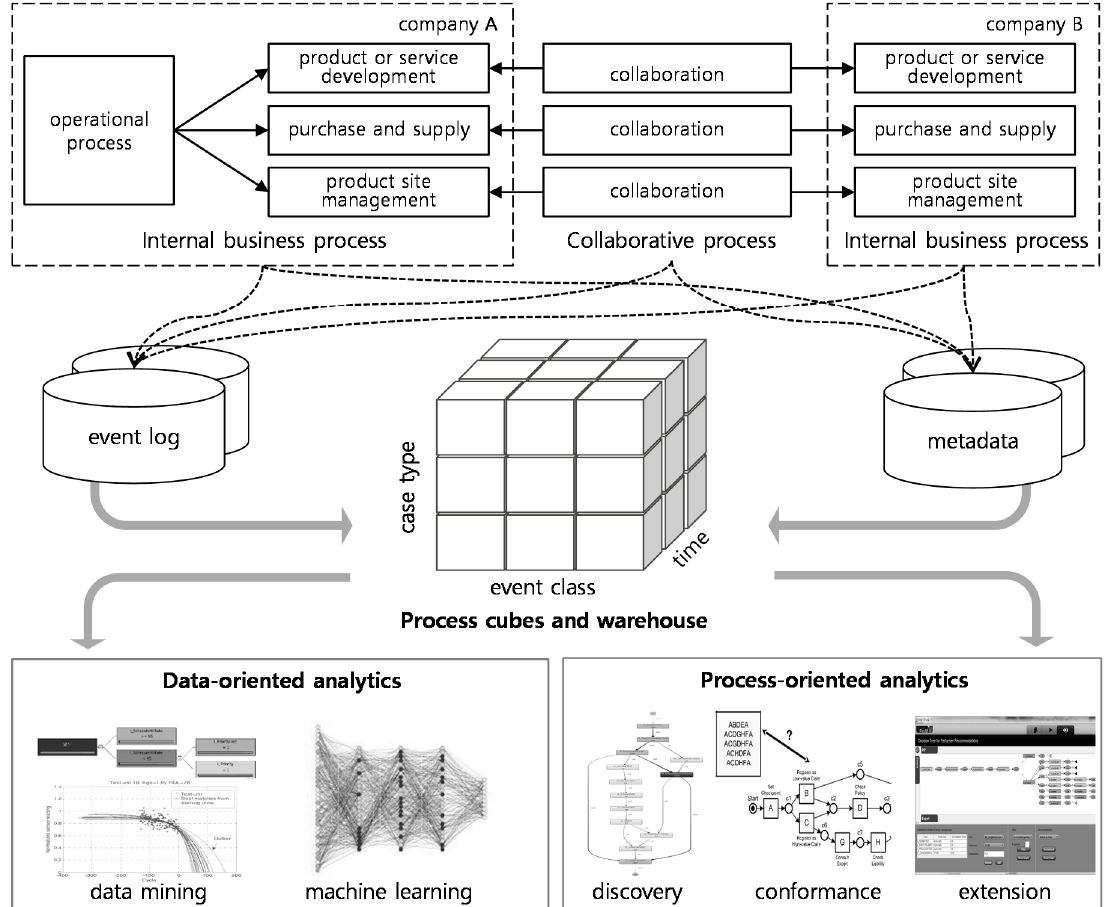
Figure 1. The framework of the process analytics system, PRANAS.